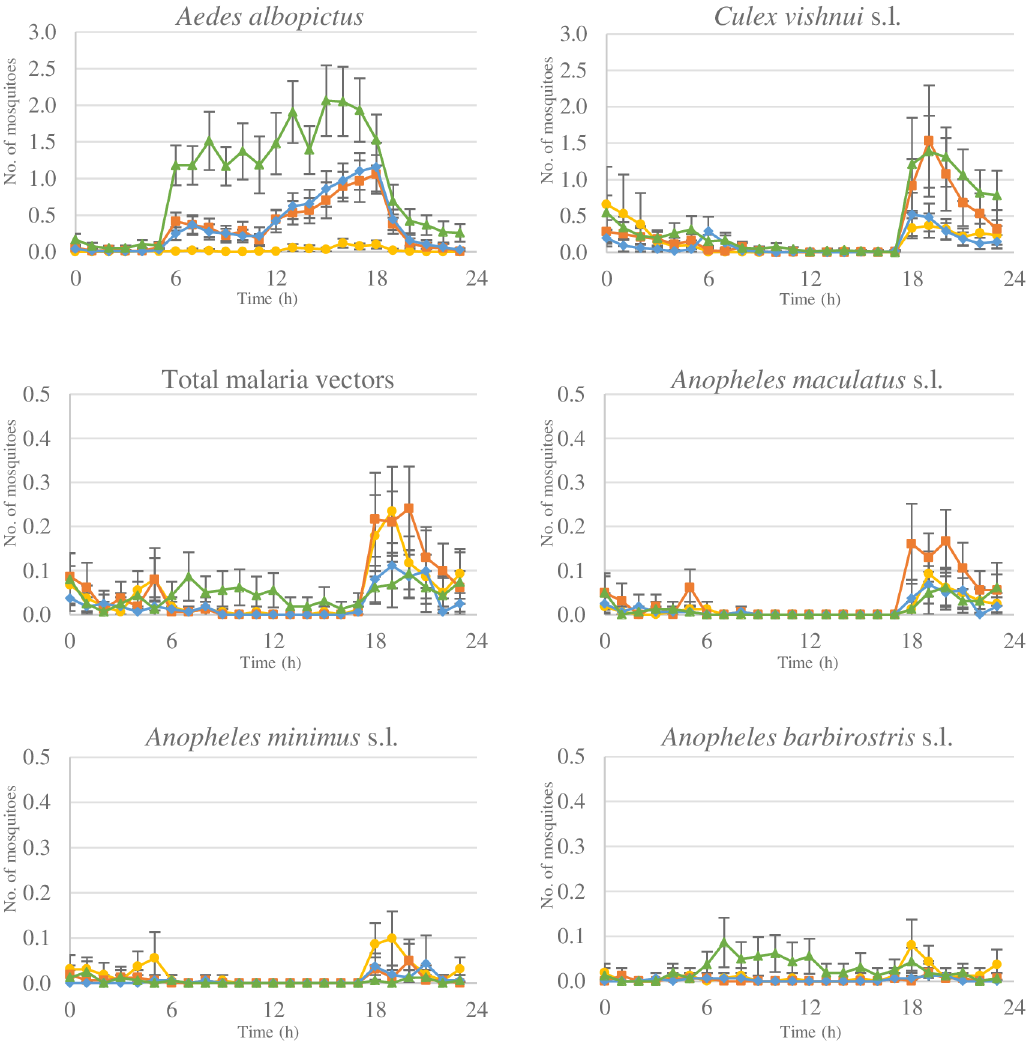
Fig 1. The averagenumber of female mosquitoes collected per person/hour in the four different habitats ( ━▲━ secondary forests, ━♦━ mature plantations, ━■━ immature plantations, ━ (cid:15) ━ villages) for Aedes albopictus , Culex vishnui s.l., total malaria vectors, Anopheles maculatus s.l., Anopheles minimus s.l., and Anopheles barbirostris s.l. during 24 hrs. All including95%